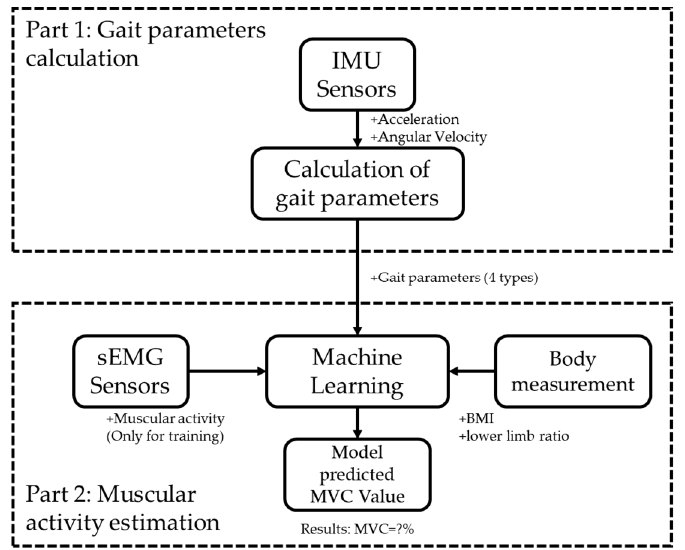
Figure 1. The overview of the system.